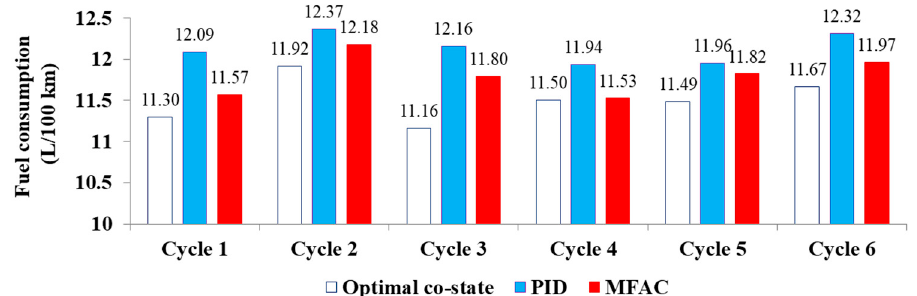
Figure 24. Fuel consumption comparison of three control methods.